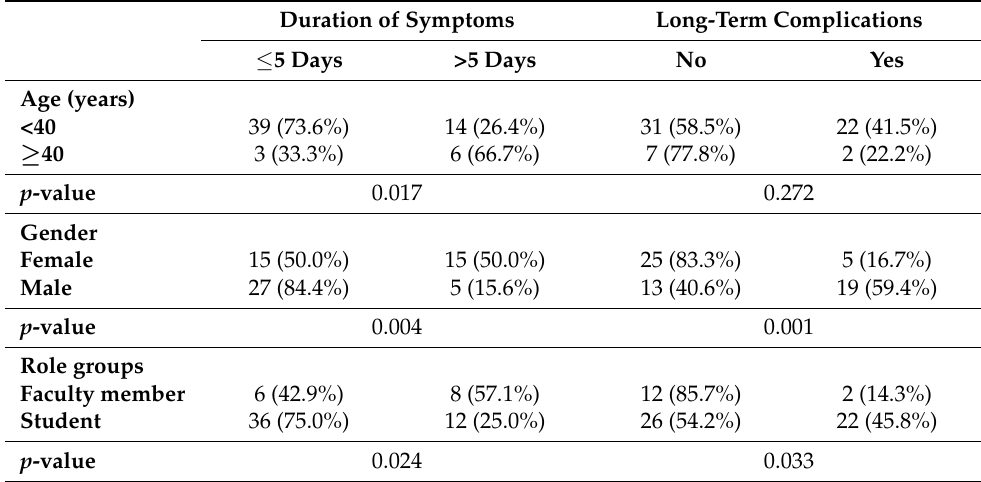
Table 3. Symptom duration in days and long-term complications/sequelae of COVID-19 infection cross-tabulated with age, gender, and role in